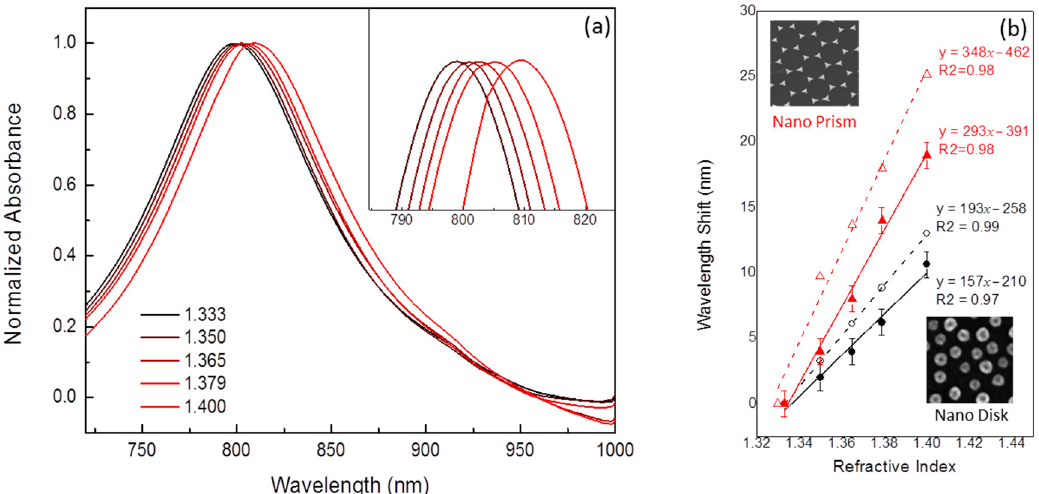
Figure 4. ( a ) Absorption spectra of Au nano-disks with an average diameter of 80 nm, exposed to different glycerol concentrations; the system was fabricated by NSL; ( b ) Comparison of the experimental and numerical calibration curves vs. a refractive index calculated for the fabricated system. In order to achieve statistically valid results, the average wavelength shift of five tests has been reported for each refractive index (RI) value. Trend-line equation and the R-square of each calibration curve are reported as well.